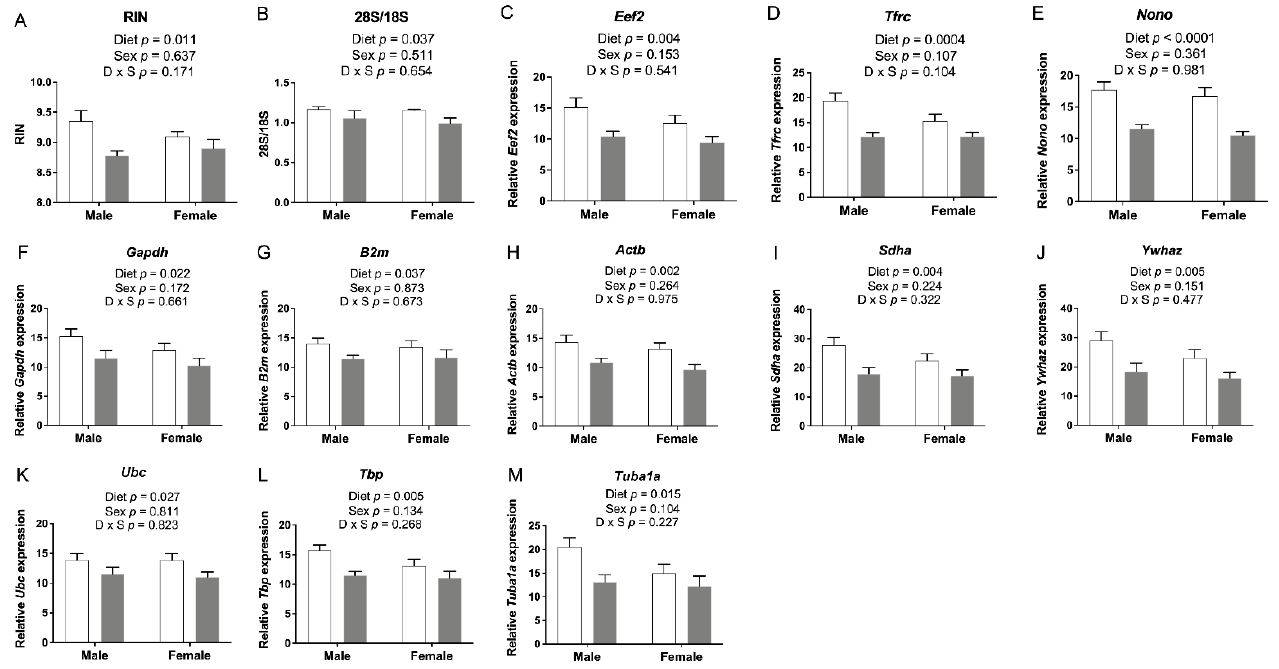
Figure 5. E17.5 cerebral RNA integrity and housekeeping gene expression. ( A ) RNA integrity number (RIN) and ( B ) 28S to 18S ribosomal RNA ratios were lower in the FASD group. ( C – M ) mRNA levels of 11 reference genes: Eef2 , Tfrc , Nono , Gapdh , B2m , Actb , Sdha , Ywhaz , Ubc , Tbp , and Tuba1a . Values are means ± SEM of 5–6 per group. White bars: CD groups; gray bars: FASD groups. p -Values from 2-factor ANOVA are indicated in each graph. CD, control diet; FASD, folic-acid-supplemented diet; D: diet; S: sex; D x S: diet x sex interaction.